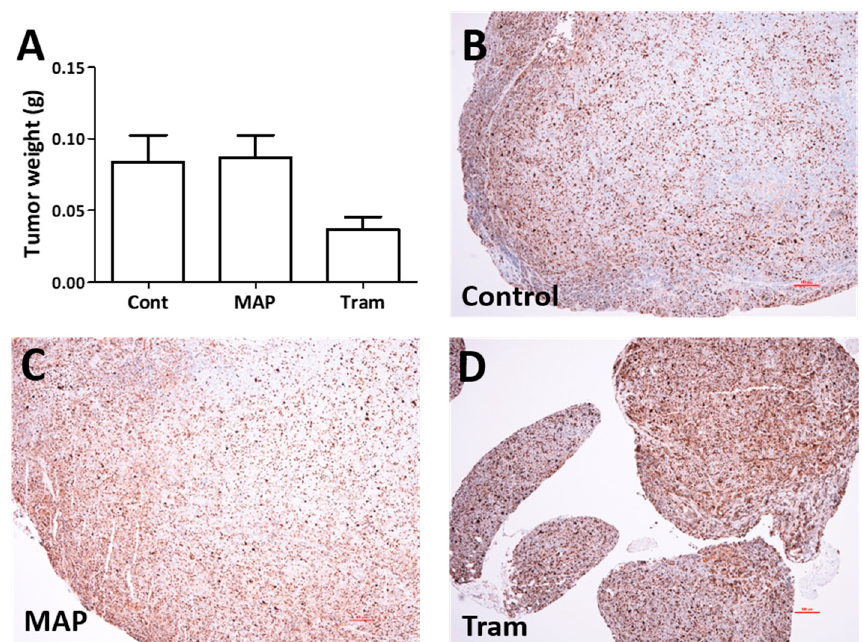
Figure 5. Effect of MEK inhibition on in vivo tumor growth. Cells were injected into the thoracic cavity of SCID mice and 6 weeks later, the animals were treated with trametinib (2 mg/kg) or MAP 855 (15 mg/kg) on three weekdays (two days apart) for three weeks. ( A ) The weight of the dissected tumor nodules at the end of the experiment. The one-way ANOVA test indicated a significant difference ( p = 0.0327). ( B – D ) Ki67-stained tumor nodules show that in the small nodules and in the periphery of the large tumor nodules, up to 90% of the cells are labelled. While in control or MAP855-treated animals, the nodules are often growing far beyond a diameter of 1 mm—we rarely observed such large nodules in the trametinib-treated animals. The scalebars represent 100 microns.